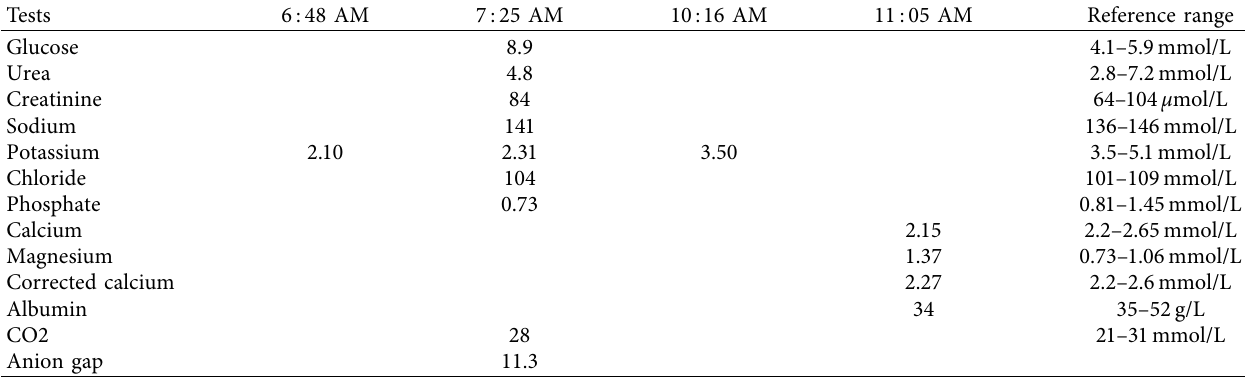
Table 1: Serum laboratory findings in the emergency